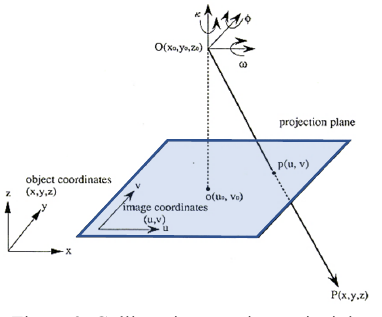
Figure 2. Collinearity equations principle.